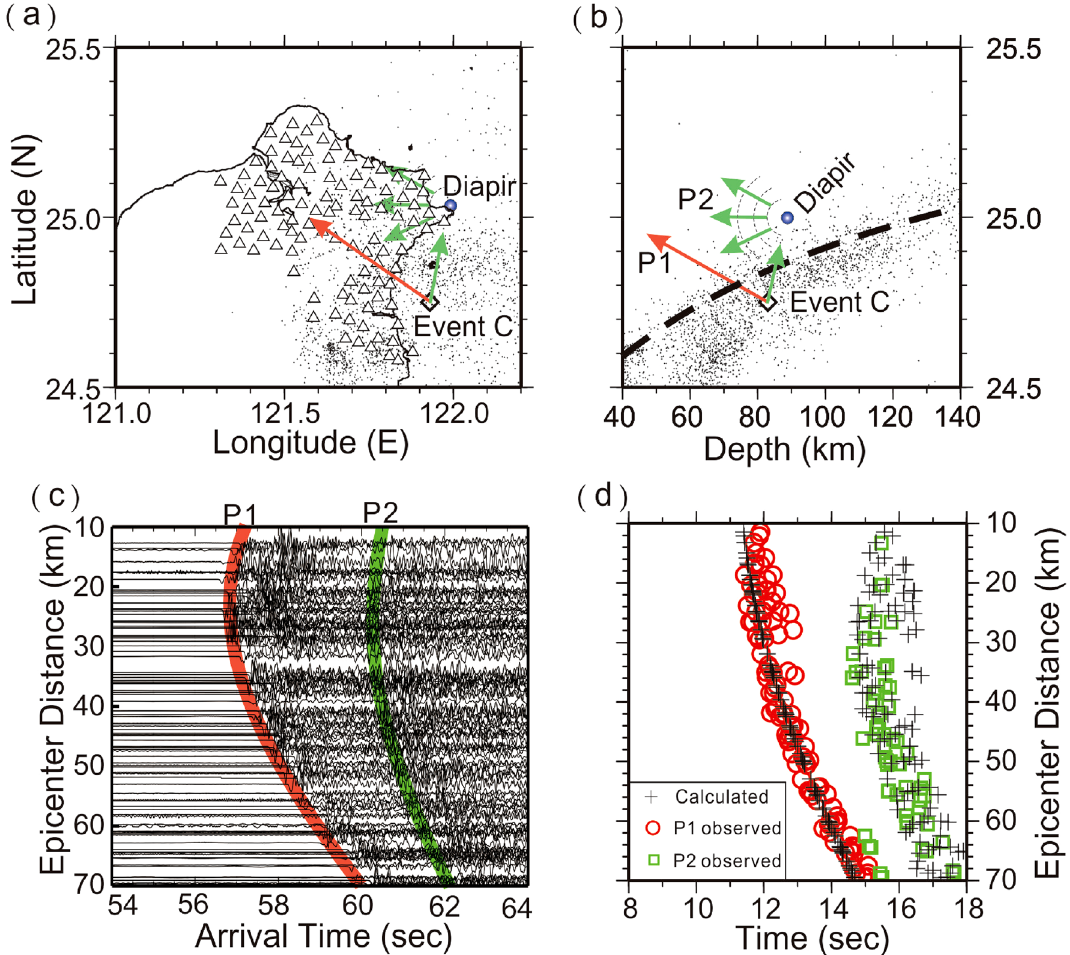
Figure 6. Locations of seismic stations (triangles), Event C (diamond) and diapir (blue circle) on the map ( a ) and depth profile ( b ). ( c ) The arrivals of P1 and P2 are, respectively, marked in red and green on the vertical seismograms plotted with epicentral distances. ( d ) The comparison between the observed arrivals of P1 (red circles) and P2 (green squares), and their calculated arrivals (pluses). This figure was partially created by Generic Mapping Tools (GMT version 4.5.2; URL: gmt.soest.hawaii.edu) and SAC software (version 101.5; URL: ds.iris.